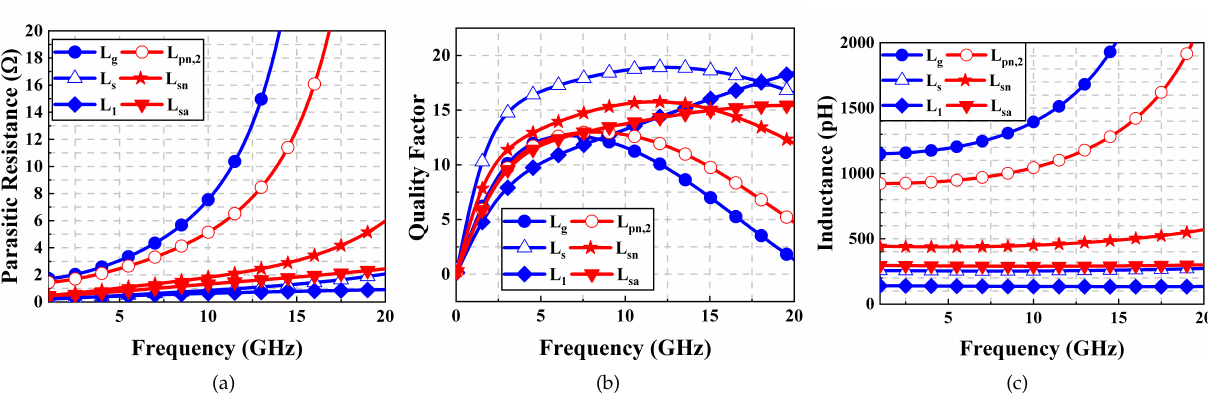
Figure 5. ( a ) Simulated parasitic series resistance of inductors; ( b ) simulated quality factor Q of inductors; ( c ) simulated effective inductance of